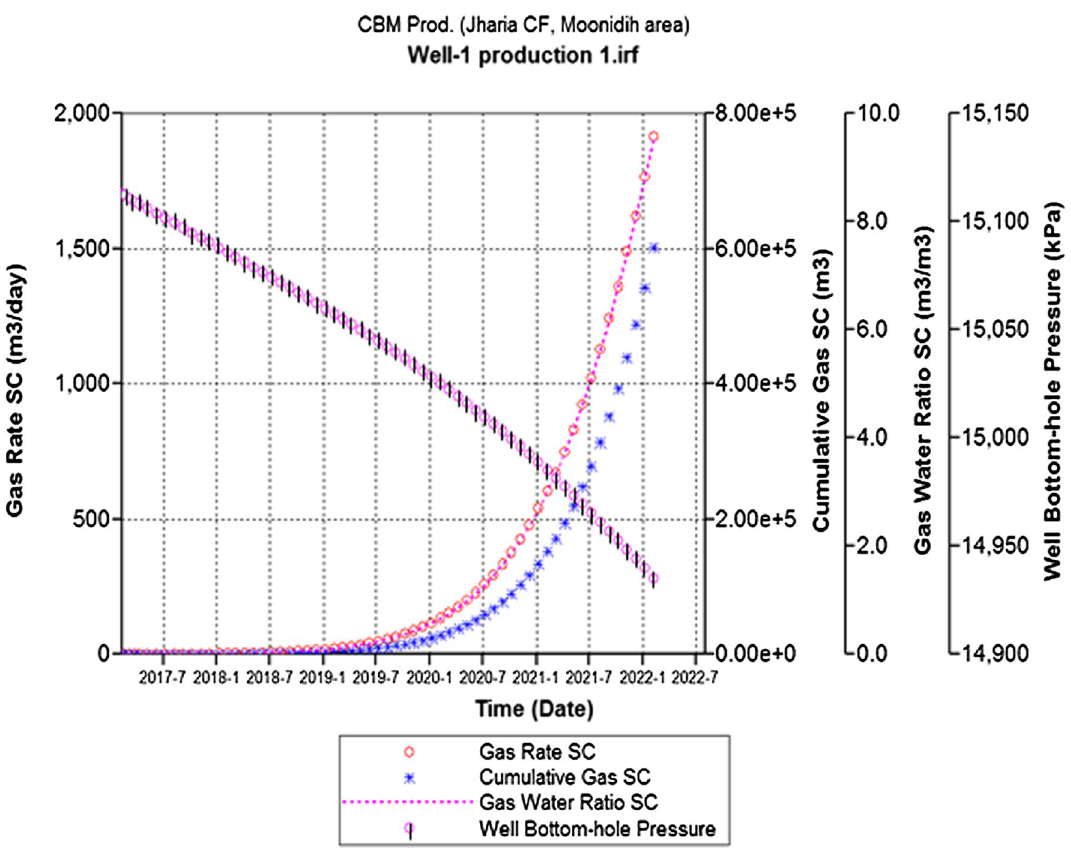
Fig. 18 Production history of production